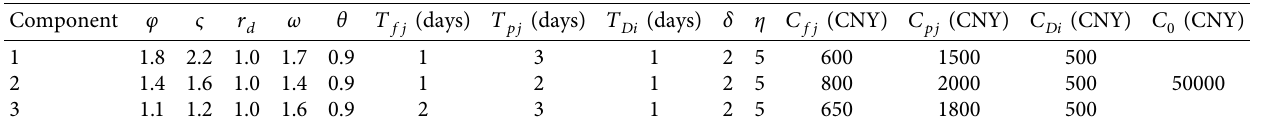
Figure 7: Optimization of PM work for components in the time dimension. Table 2: Parameter